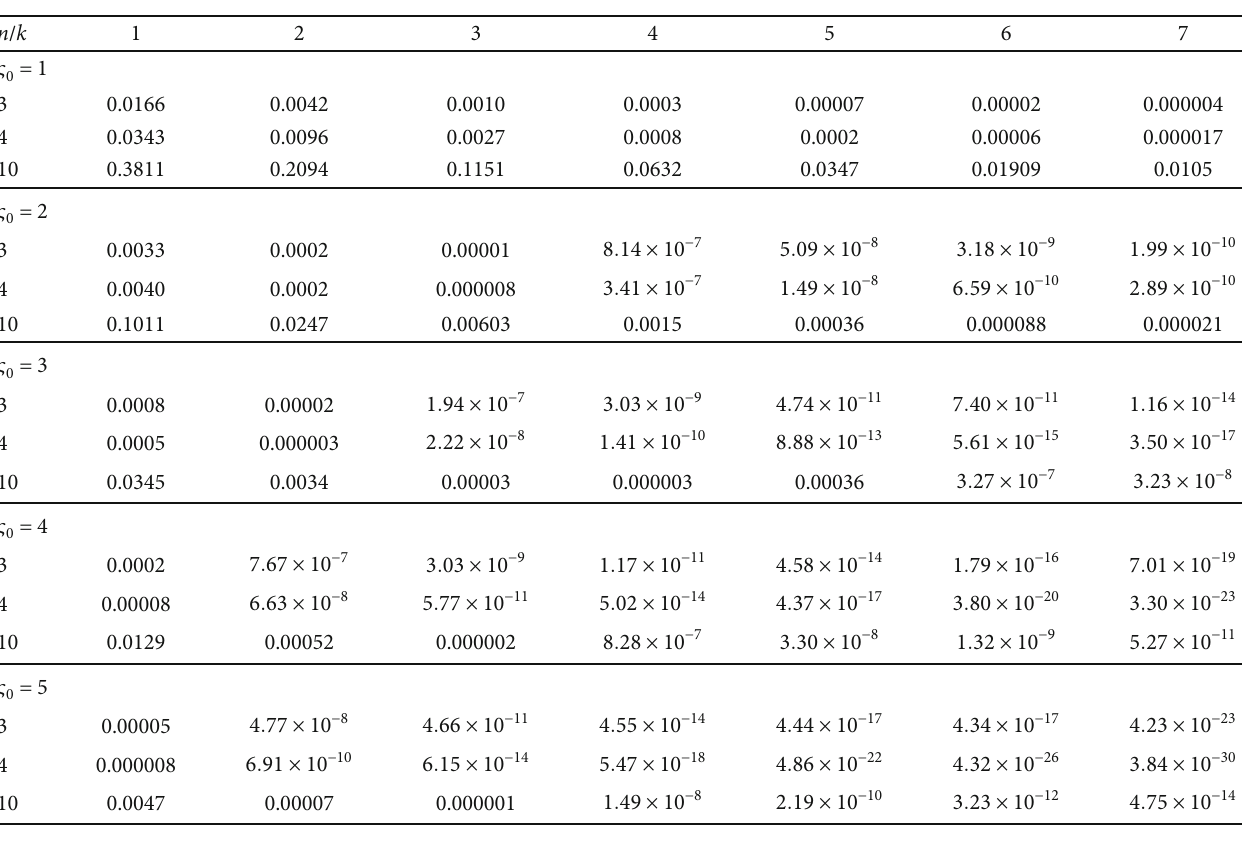
Table 2: Error bound of the uniform Doo-Sabin subdivision surfaces. Here, k presents the subdivision level, and n presents the valence